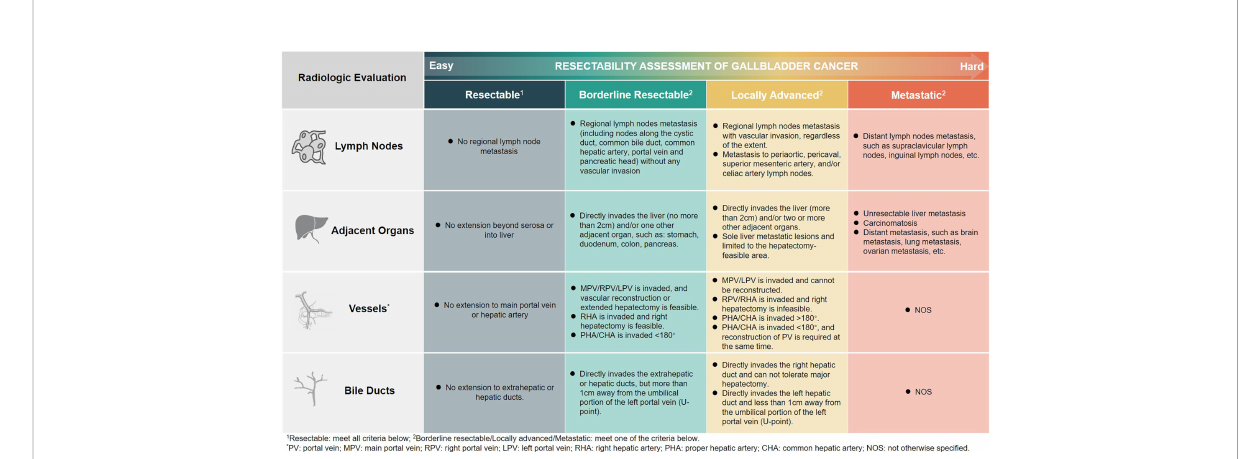
FIGURE 2 The resectability assessment of gallbladder cancer (Xinhua